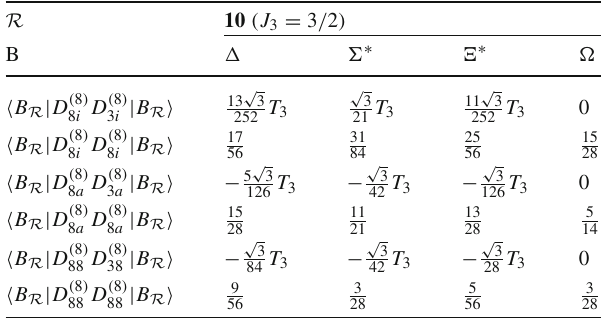
Table 6 The matrix elements of the collective operators of the m s corrections to the electric monopole form factors R